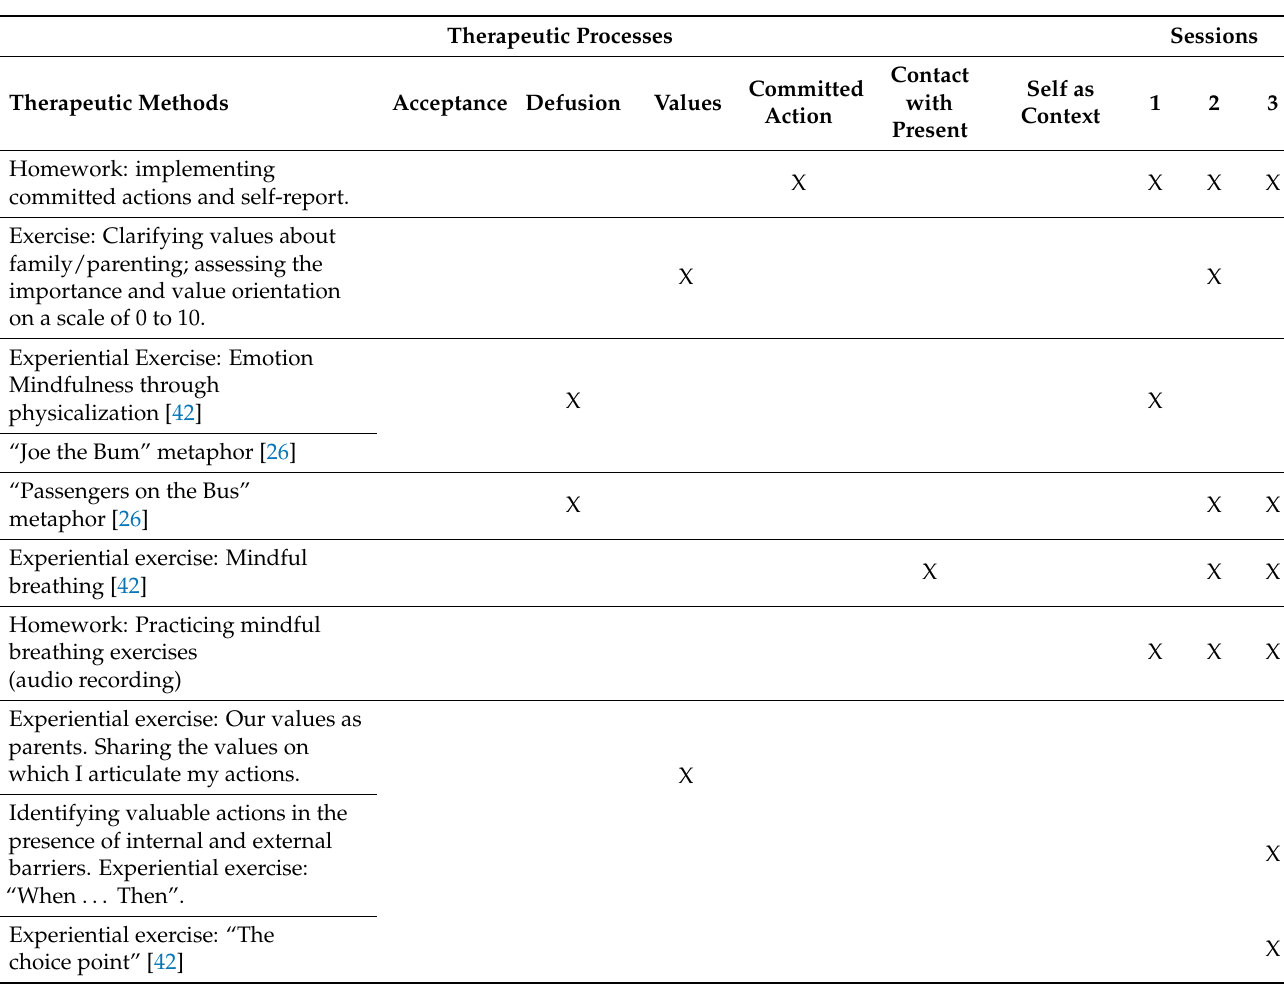
Table 1. Cont. Therapeutic